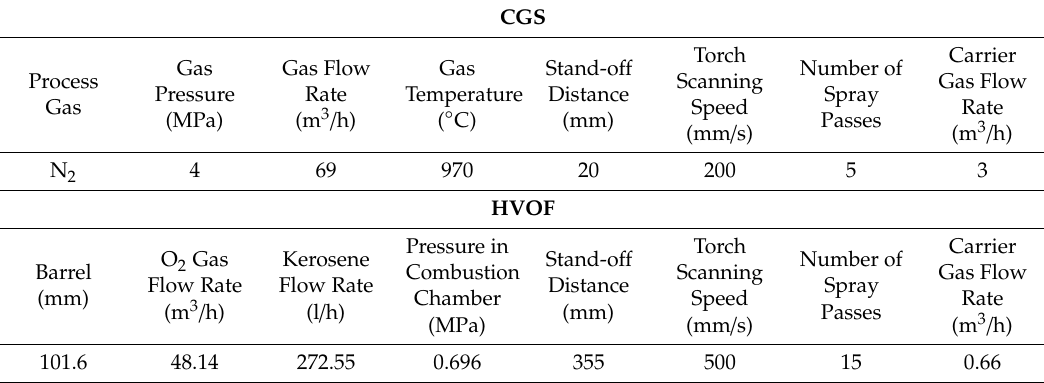
Table 2. Cold-gas spraying (CGS) and high-velocity oxy-fuel (HVOF) deposition